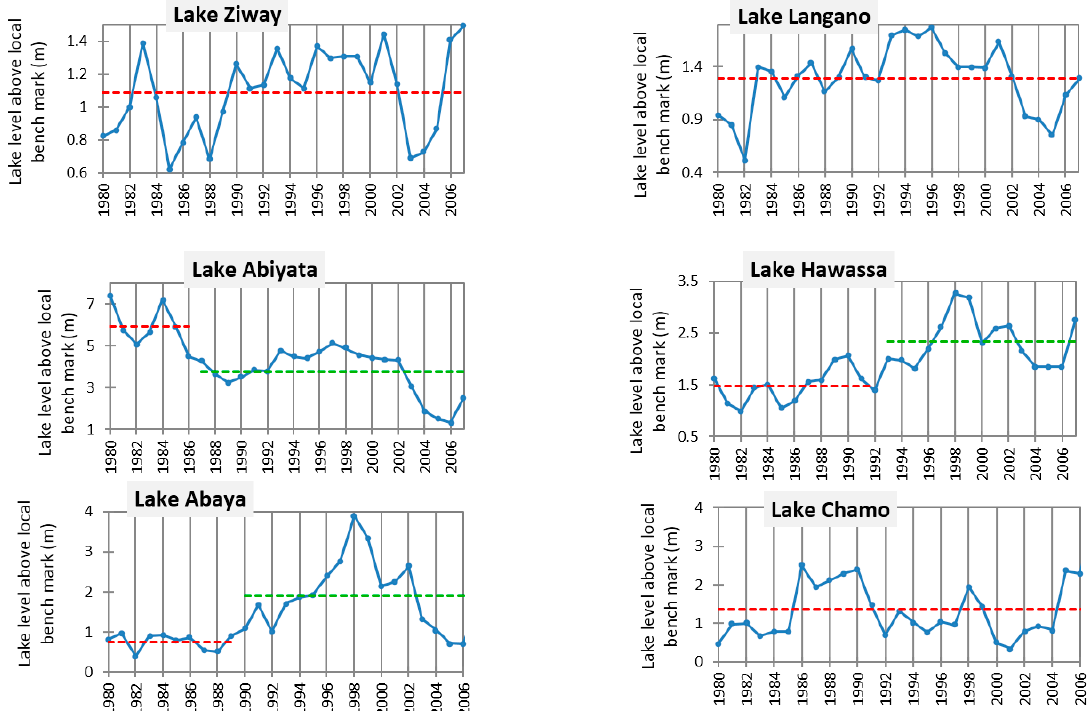
Figure 4. Long-term lake level plots of the six Ethiopian Rift Valley lakes. (N.B: (a) Analysis of regime shifts were done for the first six lakes using Pettit [34] homogeneity test. The red lines represent mean lake level before the regime shift( µ 1) and the green line after the regime shift ( µ 2). (b) Lake Shalla and Beseka are not included in this result due to availability of time series data during the study)